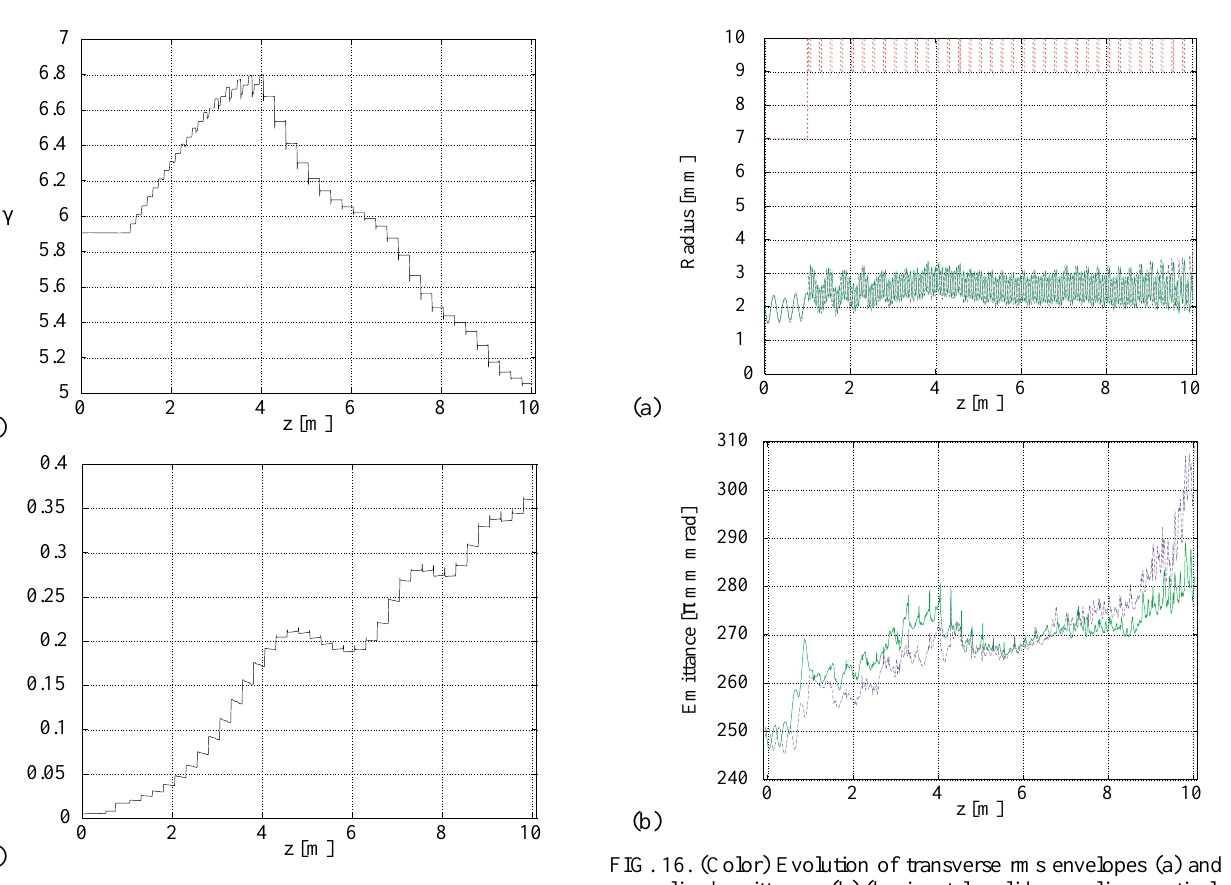
FIG. 15. Evolution of (a) microbunch centroid energy and (b) normalized rms energy spread during afterburner operation.